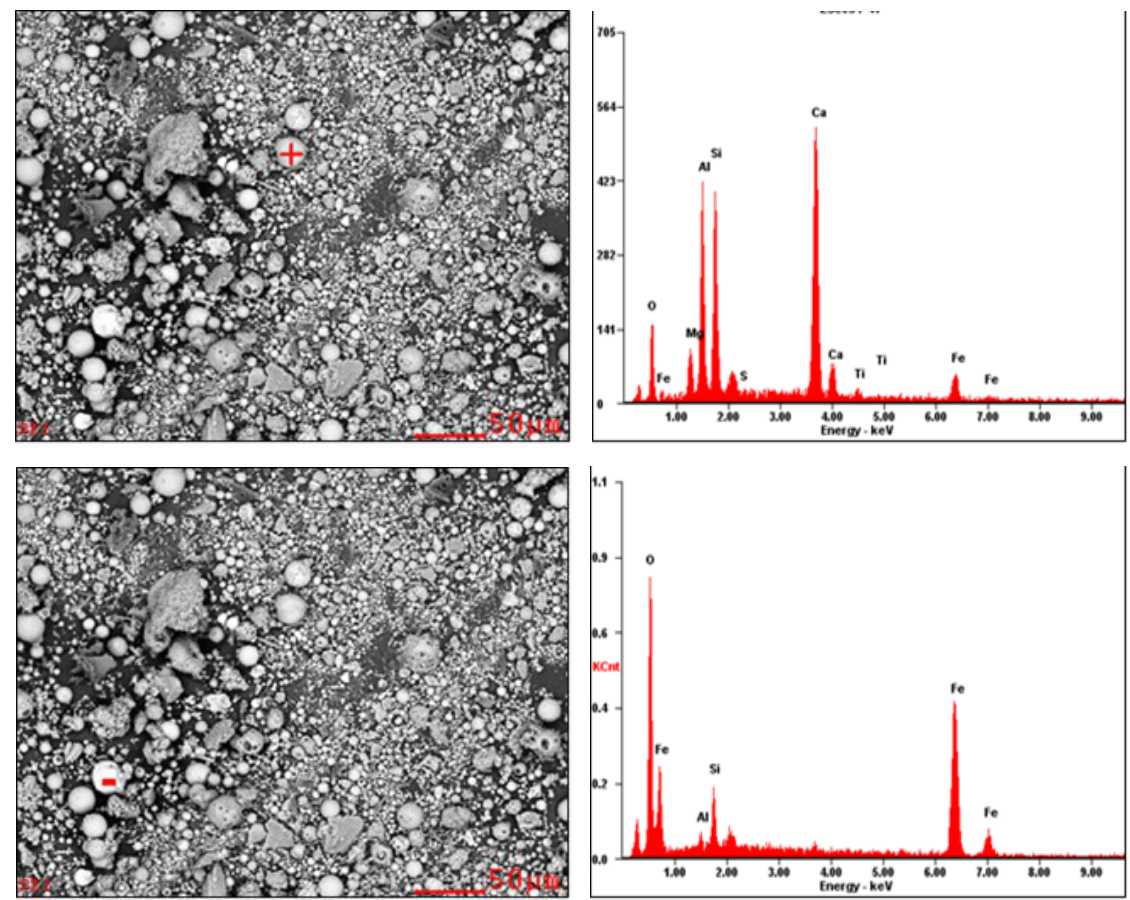
Fig. 3. SEM images and EDX spectra of ashes collected in